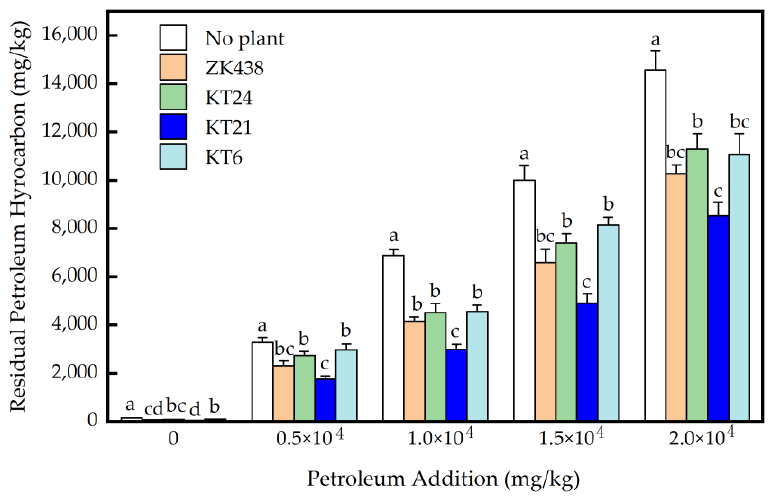
Figure 3. Residual petroleum hydrocarbons (C 10 -C 40 ) in salinized soils after 70 days through the planting of the four S. bicolor varieties. (Different letters within the same petroleum addition indicated significant variances ( p < 0.05) among different treatments.)